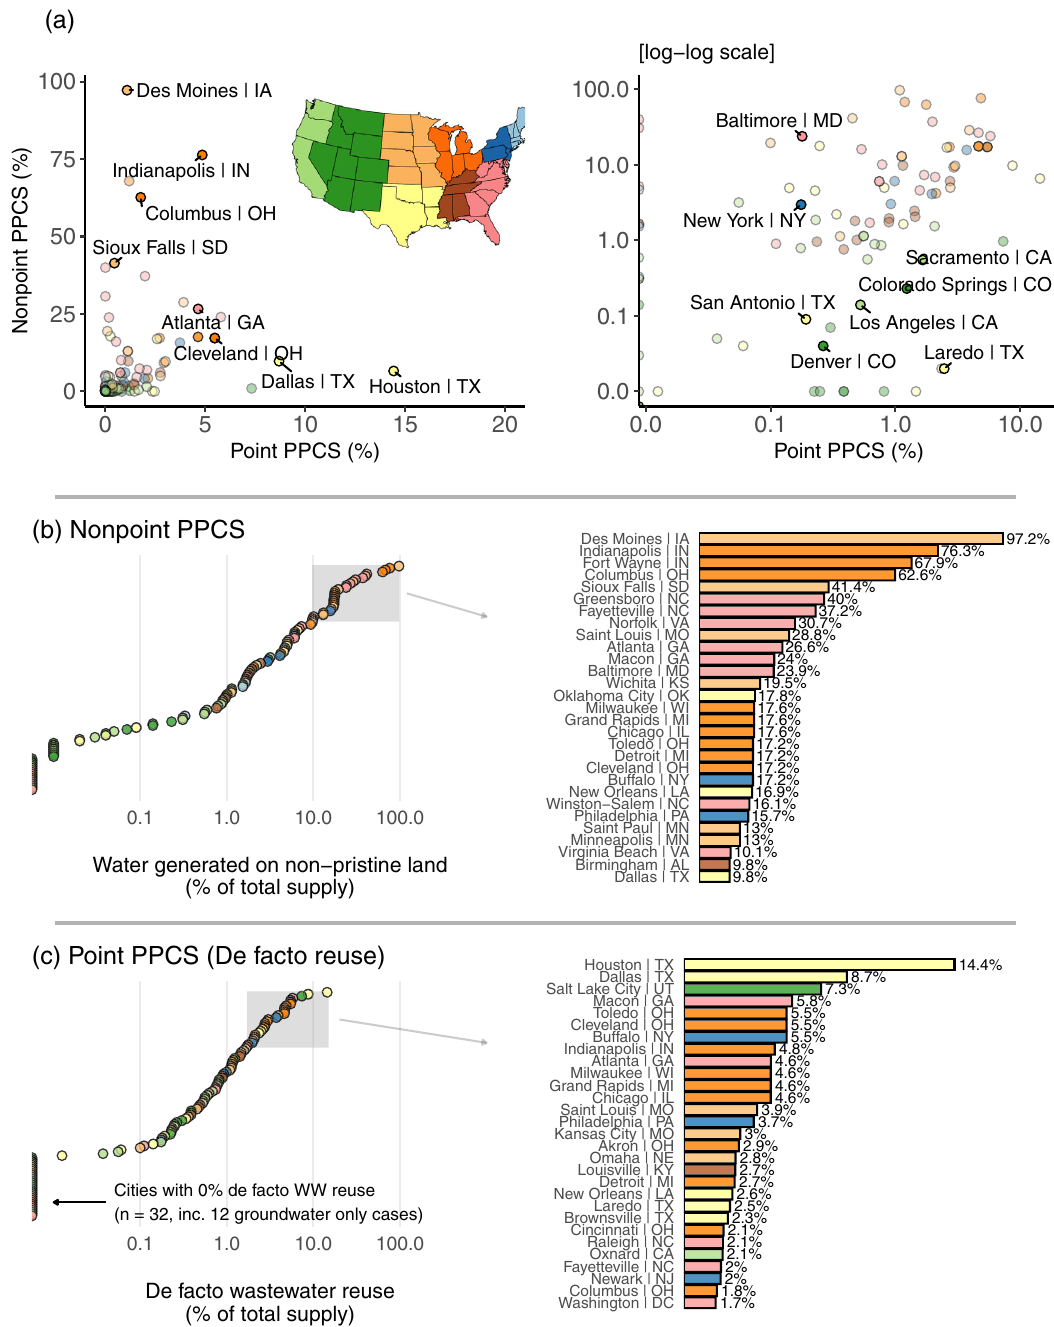
Fig. 3 The wide disparity in potential contamination across U.S. cities. Total water supply contamination levels for each city given in scatter plot ( a ). b , c Show the ranked distributions of nonpoint and point PPCS, respectively. In b , c the top quartile ( n = 29) of cities is highlighted. Point color gives U.S. Census division — see map insert in ( a